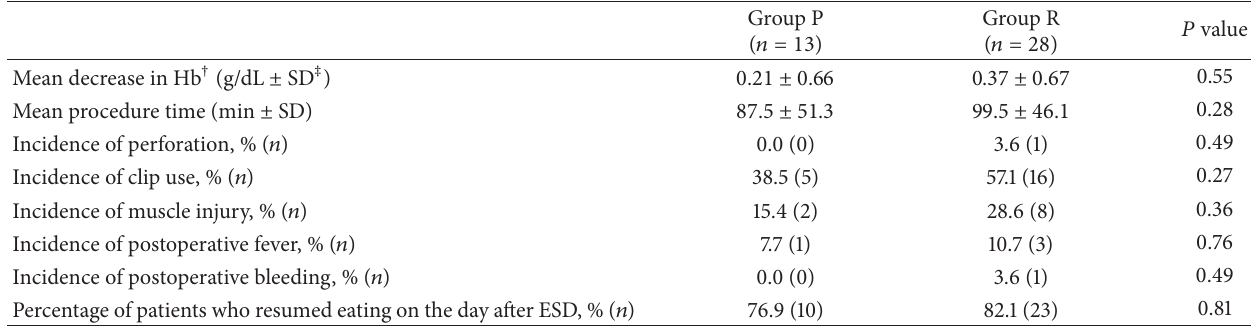
Table 3: Results for lesions in region U/M.